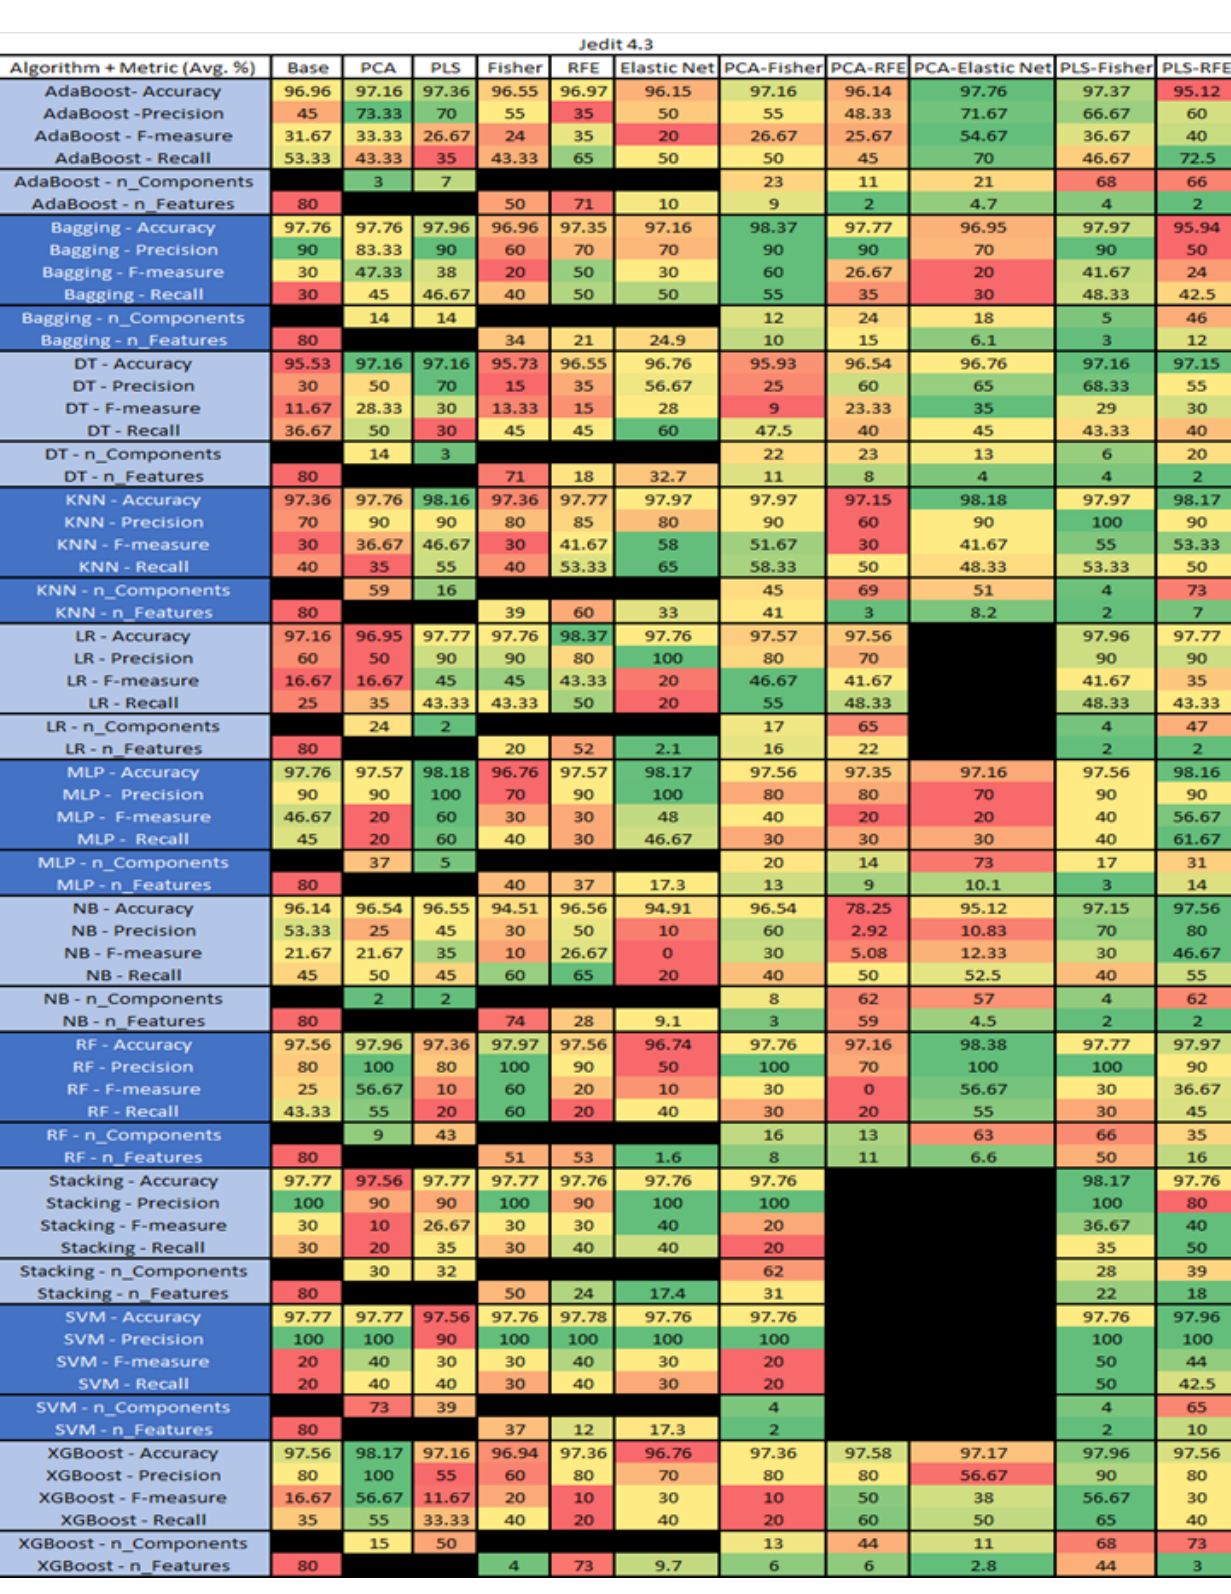
Figure 22. Jedit 4.3 PROMISE Results Data